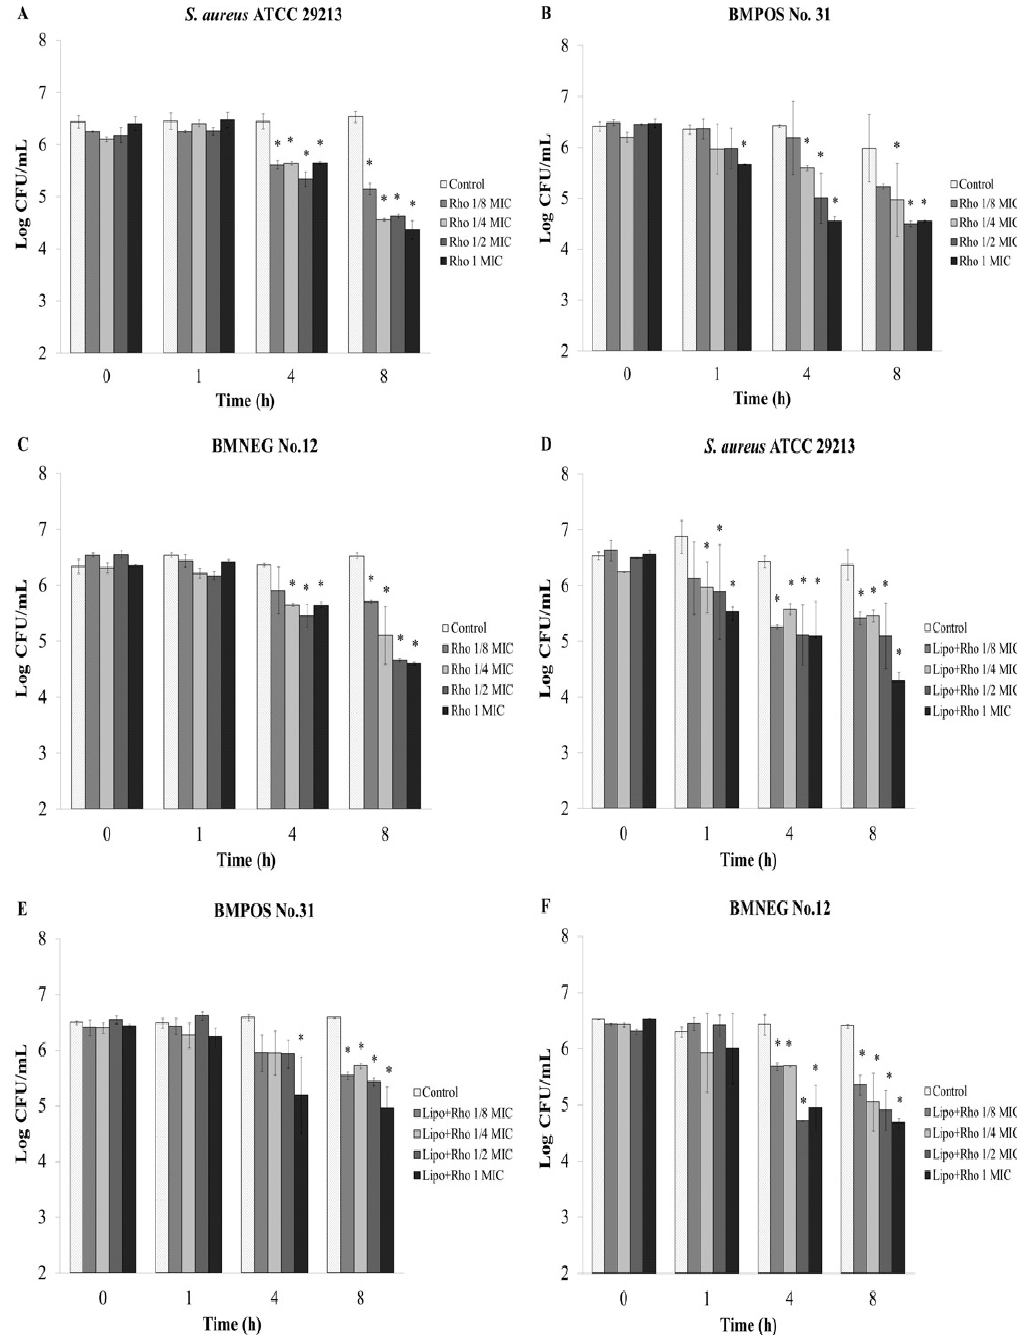
Figure 3. Quantification of bacterial adherence by ex vivo anti-adhesion assay. Each bar represents the number of adherent bacteria to the bovine udder tissue evaluated by a viable plate count. Bacterial isolates were treated with 1/8 × minimum inhibitory concentration (MIC), 1/4 × MIC, 1/2 × MIC, and 1 × MIC of rhodomyrtone; Rho ( A – C ) or liposome encapsulated rhodomyrtone; Lipo + Rho ( D – F ) at various time points (h). 1% DMSO was used as a control. The data represent the pooled results from two experiments and are expressed as a mean value ± standard deviation (SD). * p < 0.05, compared to the control.